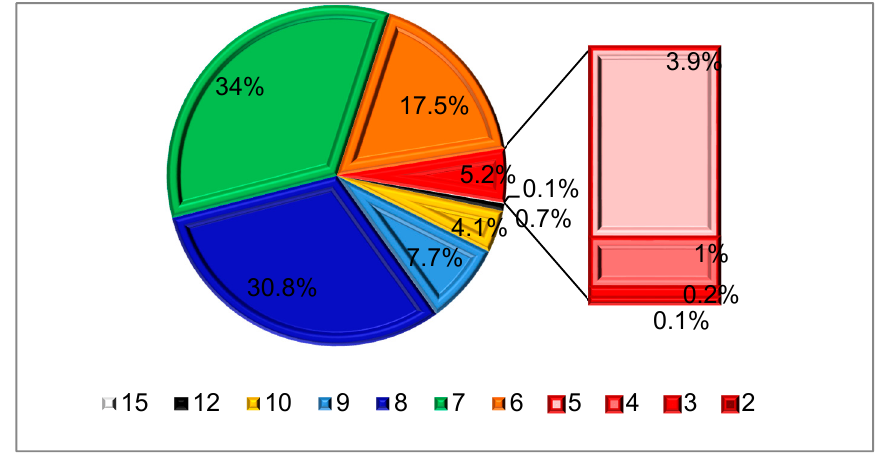
Figure 1. Distribution depending on sleep duration (h).